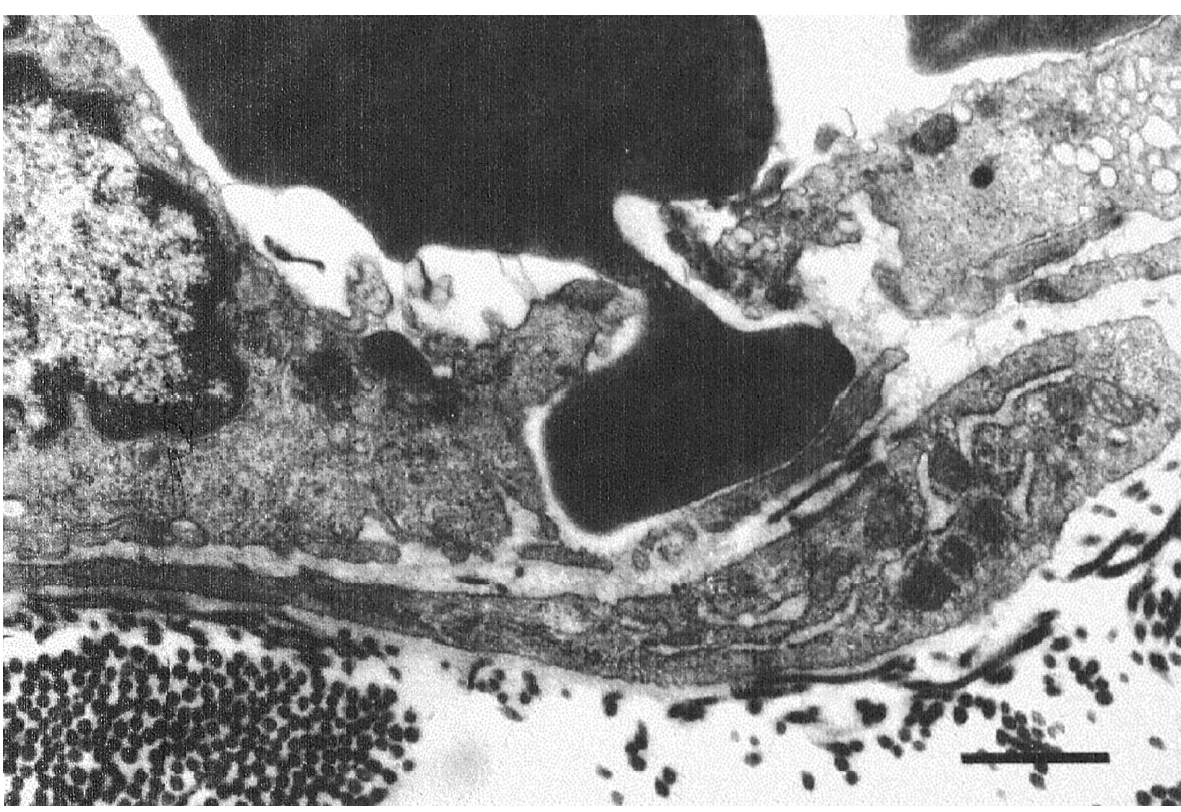
FIG. 2. Electron micrograph of a venule 1min after injection of 2.5 m g of B. jararaca venom showing an erythrocyte escaping through an endothelial junction (bar=0.5 m m).